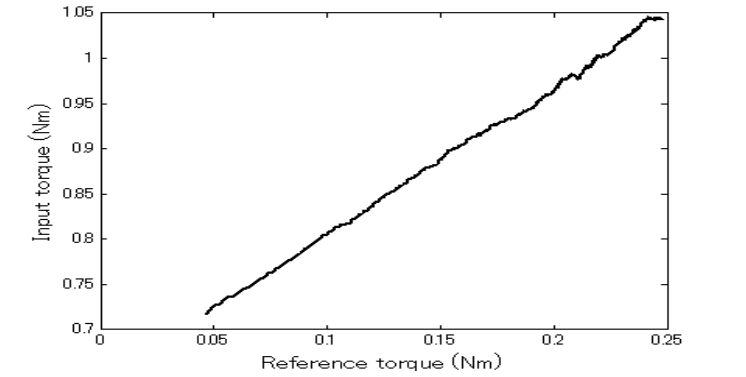
Figure 4. The relationship between the input and output torque.